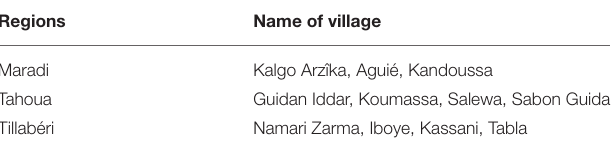
TABLE 1 | Villages participating in the survey. Regions Name of